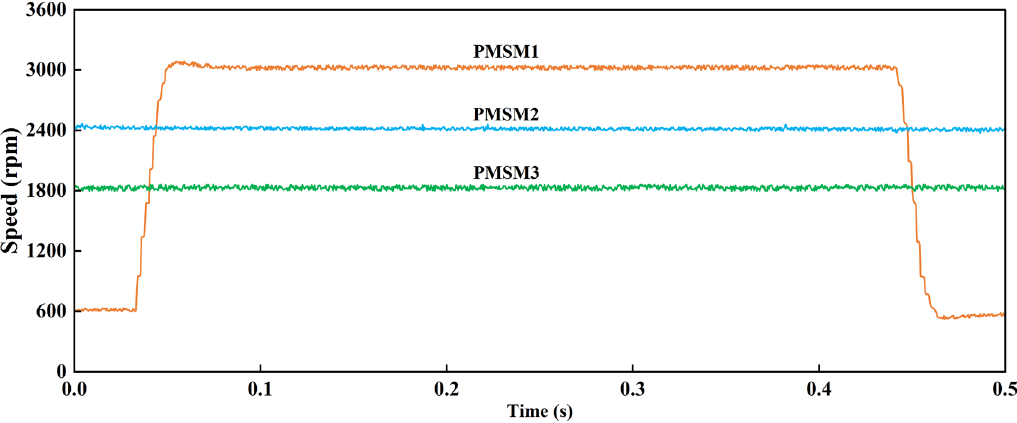
Figure 20. The diagram of test result with speed step commands.